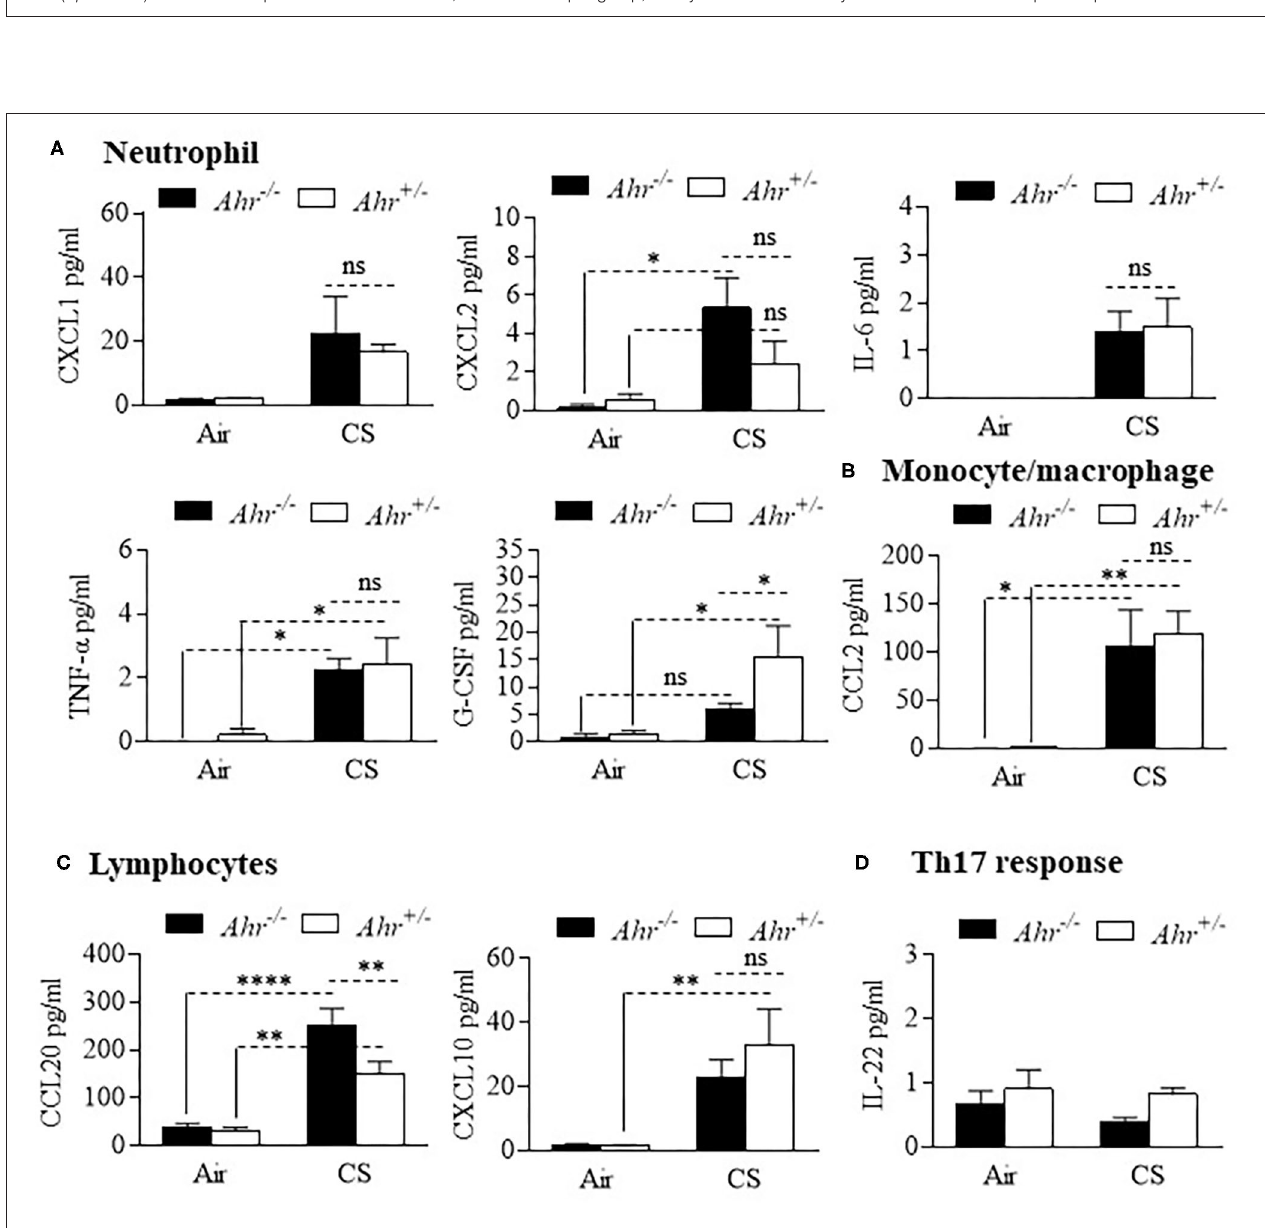
FIGURE 2 | Differential analysis of BAL cytokines is similar between smoke-exposed Ahr + / − and Ahr − / − mice. Ahr + / − and Ahr − / − mice were exposed to an 8-week CS regime and cytokines analyzed in the BAL fluid by multiplex analysis. (A) Neutrophils- there was an overall increase in the levels of CXCL1, CXCL2, IL-6, TNF- α , and G-CSF after 8 weeks of cigarette smoke exposure; except for G-CSF, there was little difference between smoke-exposed Ahr + / − and Ahr − / − mice (* p < 0.05; ns = not significant). (B) Monocyte/macrophage- although CS increased BAL levels, there was no difference in CCL2 between Ahr + / − and Ahr − / − mice (** p < 0.01). (C) Lymphocytes- there was a significant increase in CCL20 in response to CS; there was significantly more CCL20 in the BAL of smoke-exposed Ahr − / − mice (** p < 0.01; **** p < 0.0001). (D) Th17 response- IL-22 was unaffected by smoke exposure or AhR expression. Results are shown as means ± SEM ( n = 4–5 mice per group); 2-way ANOVA followed by the Neuman-Keuls multiple comparisons test.